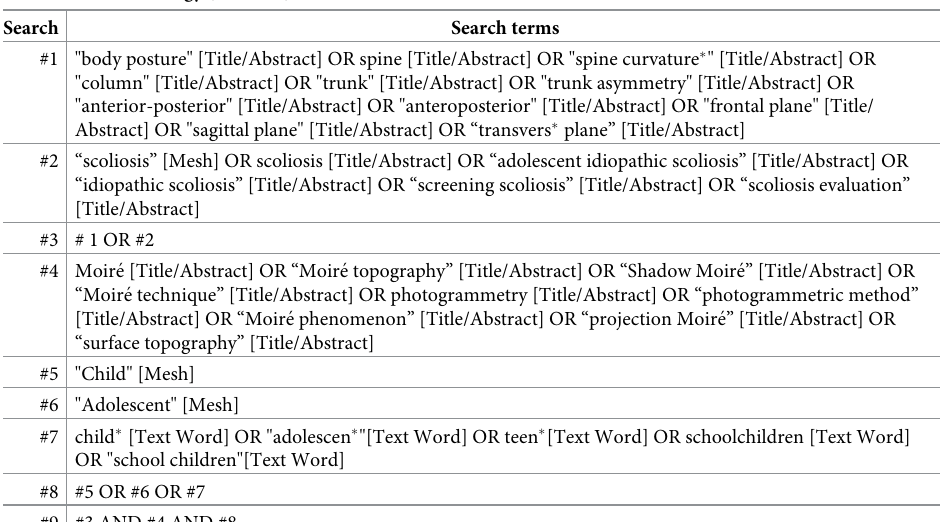
Table 1. Search strategy